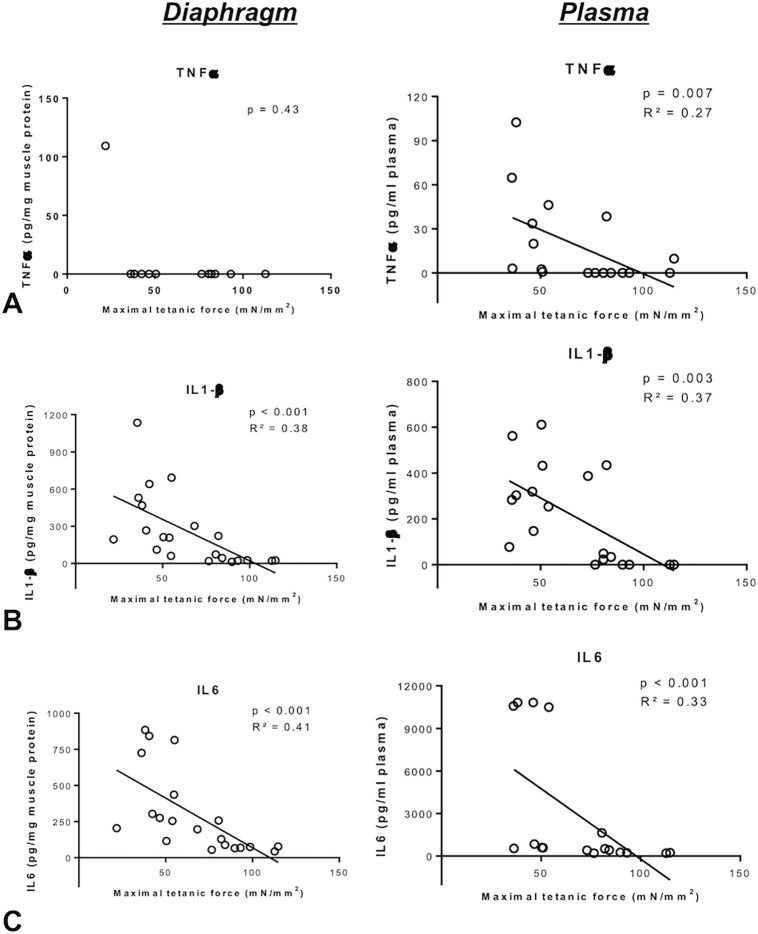
Relationship between maximum isometric tetanic force of the diaphragm and tumor necrosis factor (TNF)-α (Panel A), interleukin (IL)-1β (Panel B) and IL-6 (Panel C) protein concentration in the diaphragm (left panels) and in the plasma (right panels). Correlation determined by Spearman test.